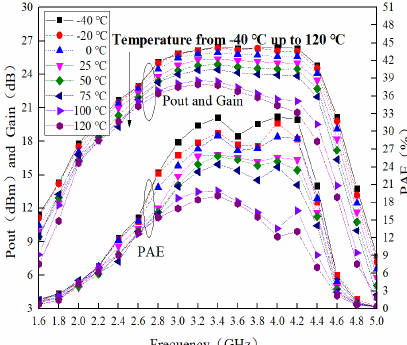
Figure 11. Measured curves of RF output characteristics at different temperatures: ( a ) 2.4 GHz; ( b ) 3.4 GHz; ( c ) 4.4GHz.